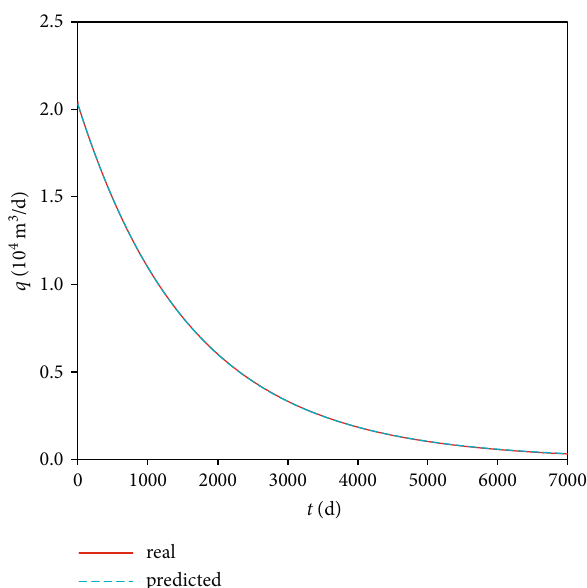
Figure 22: The real q pro fi le and the predicted pro fi le by the HDM for Case 2-1.